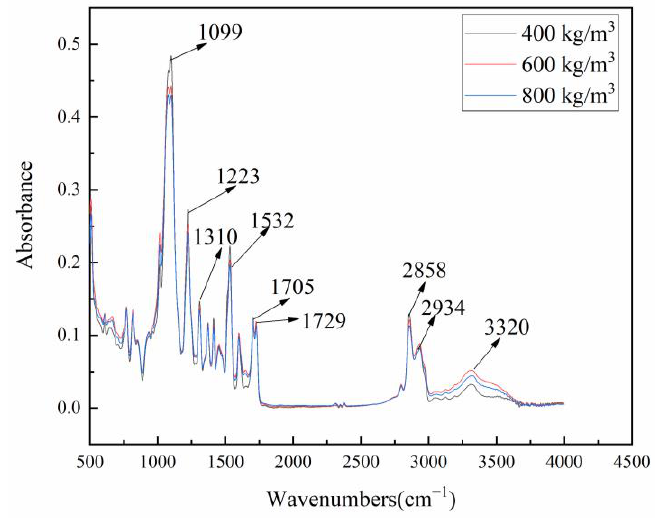
Figure 3. Typical PUME waveforms in SHPB experiments: ( a ) incident and reflected waves, ( b ) transmitted waves.